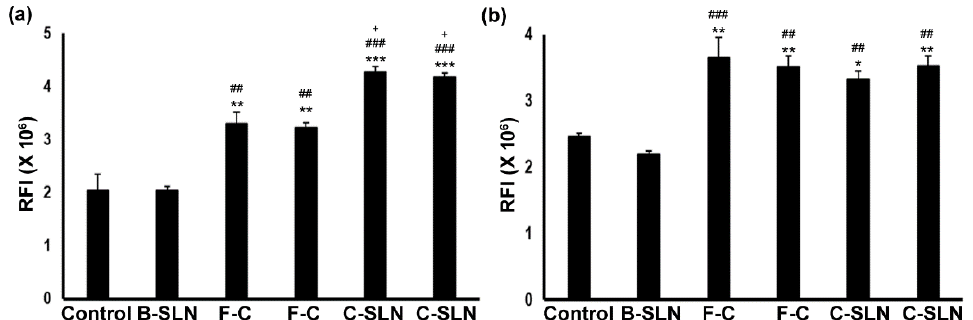
Figure 4. ( a ) Proliferative effect of CSLN on human keratinocytes (HaCaT) and ( b ) fibroblast (FB) cells. The bar heights represent the relative fluorescence intensities (RFI) of reduced Alamar Blue reagent (1 h incubation) after 48 h of treatment with the control, BSLN (8 µ g/mL), FC, and CSLN (0.01 and 0.1 µ g/mL, respectively). Data are expressed as mean ± SEM ( n = 3 independent experiments, 9 wells/condition). * indicates a difference between the control to the other groups; # indicates a difference between BSLN to other groups, while + indicates a difference between FC and CSLN. + p < 0.05, **/## p < 0.01, and ***/### p <